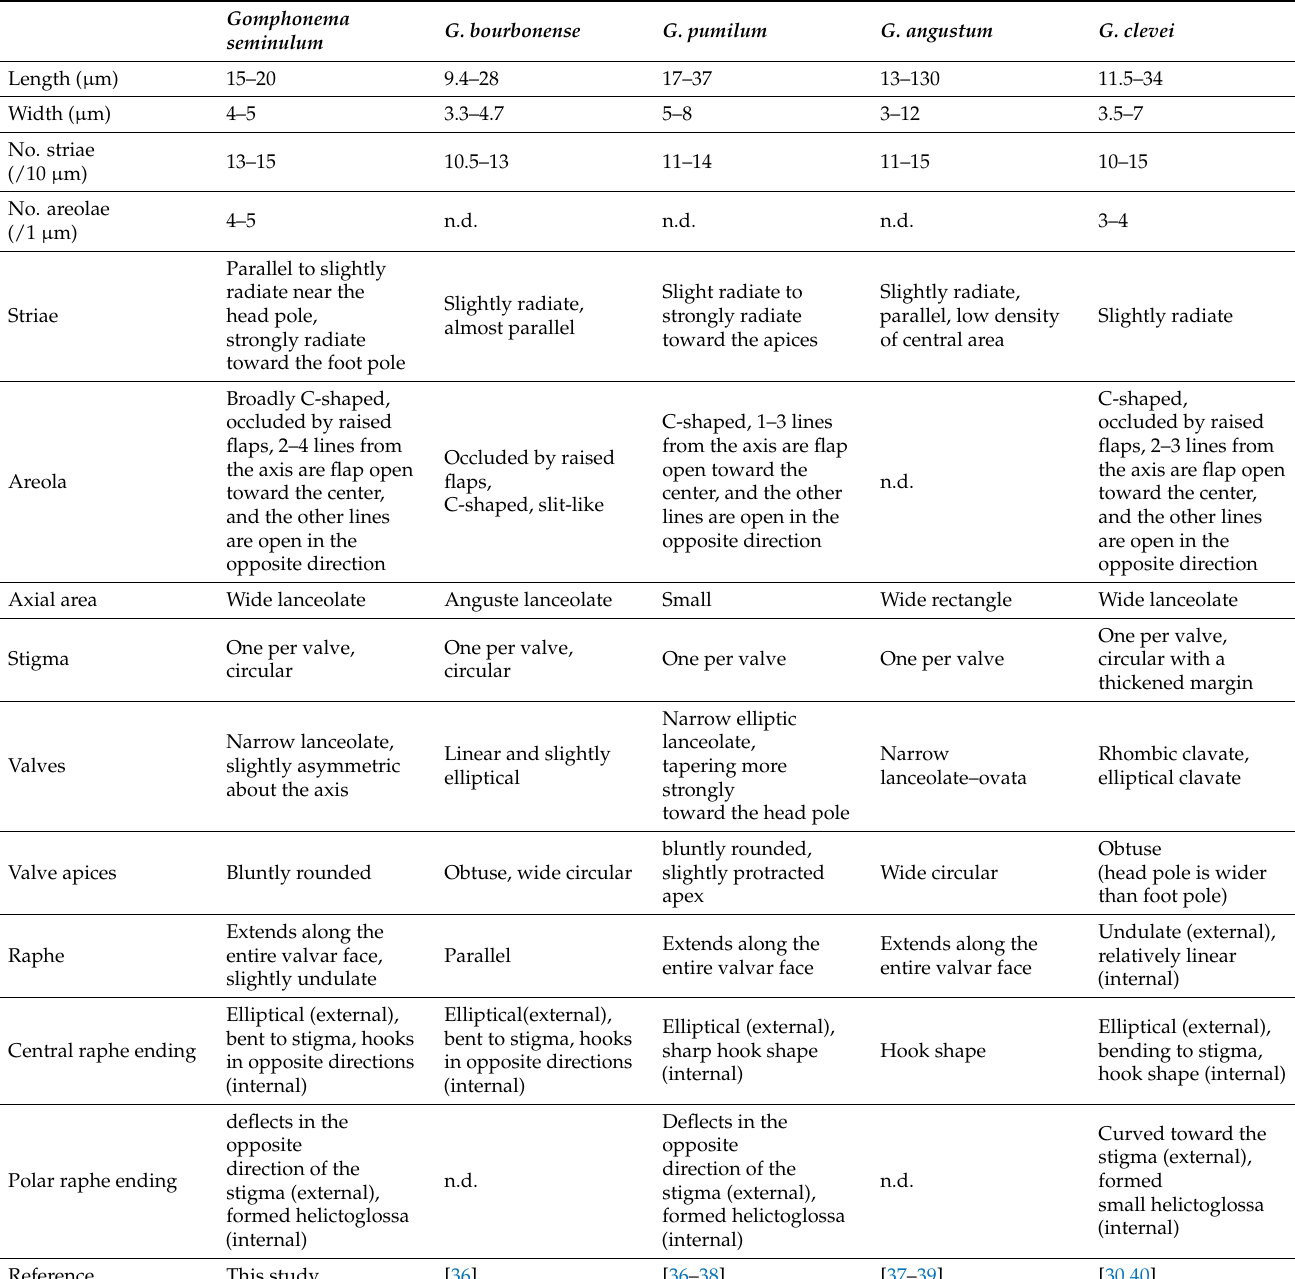
Table 5. Comparison of morphological characteristics for Gomphonema seminulum sp. nov. and closely related